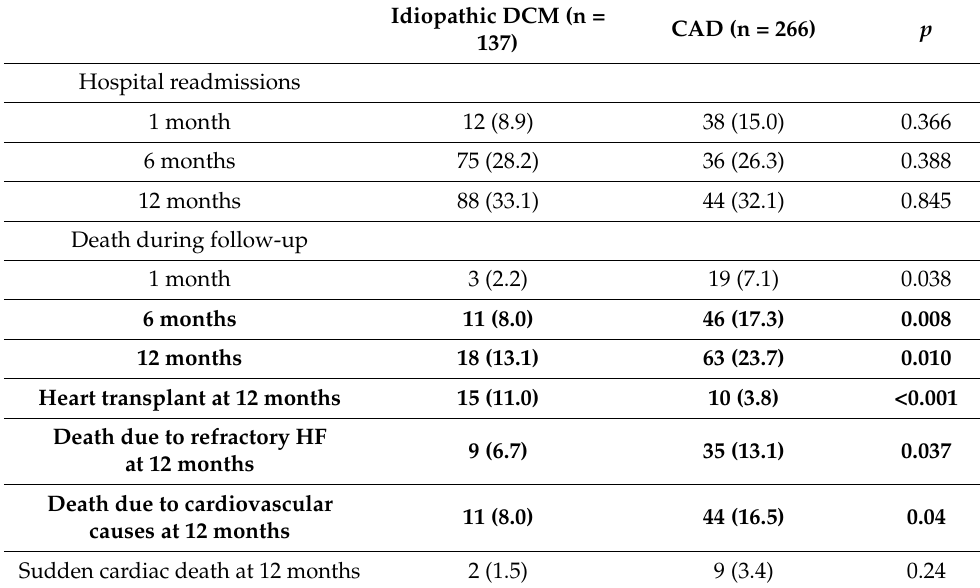
Table 3. Events during follow-up and independent predictors of 12-month mortality and